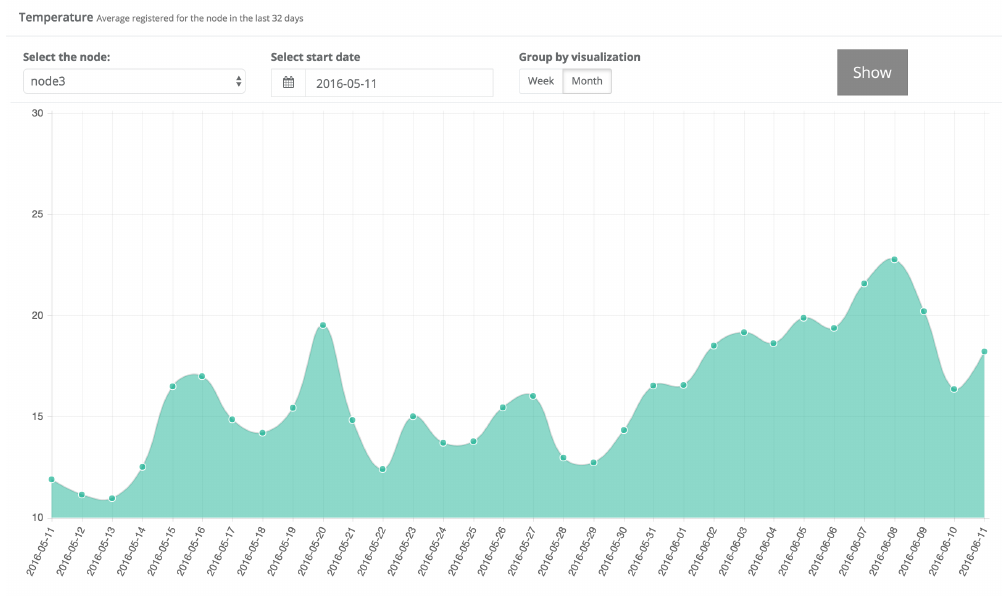
Figure 11. Average daily temperature values collected by node 3.